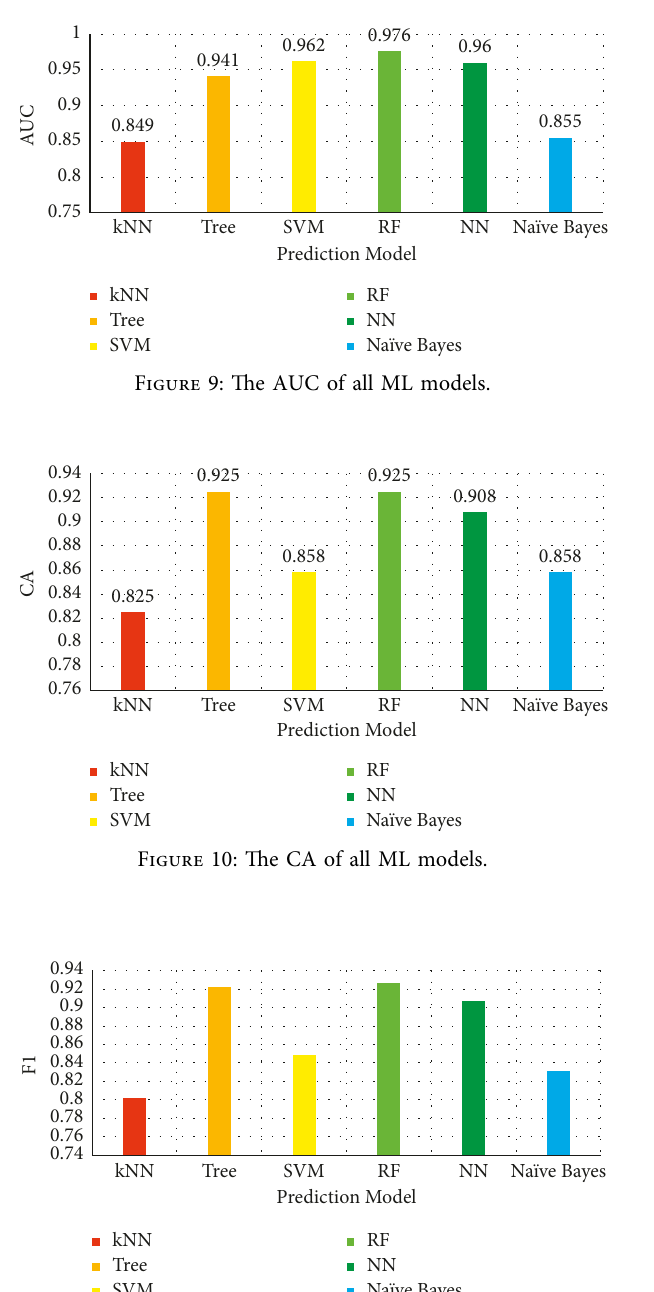
Figure 11: The F1 of all ML models.